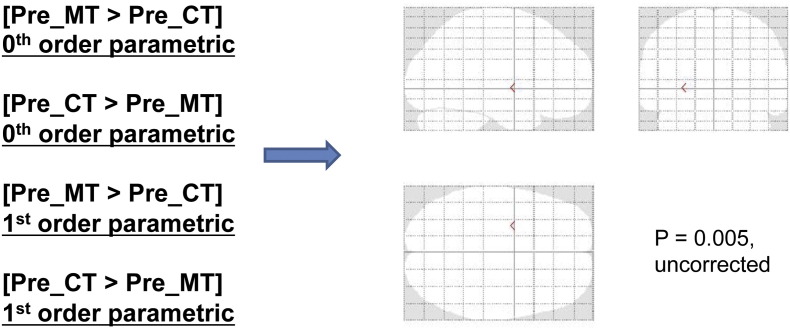
There are no pre-existing differences across the two groups when looking at both the 0th order and 1st parametric regressors (p < 0.005, uncorrected). This null result verifies that our analyses do not confound any pre-existing differences between the groups.